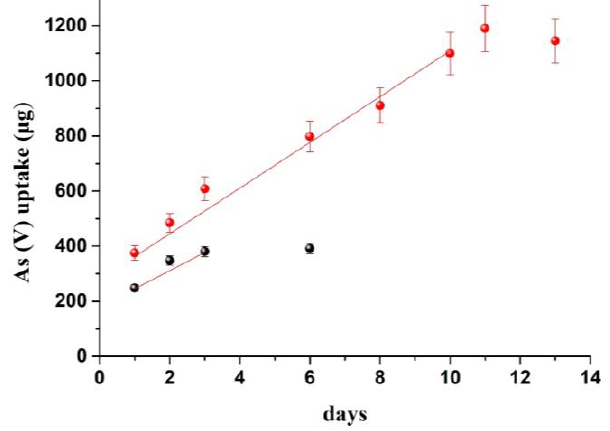
Figure 5. Kinetic update data of 1 mg/L of As(V) from lake water. Black line: uptake on 12.56 cm 2 MOR−1 @cotton fabric. Red line: uptake on 45 cm 2 MOR−1 @cotton fabric.